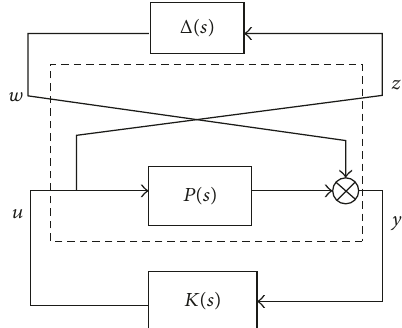
Figure 4: Linear fractional model of uncertain